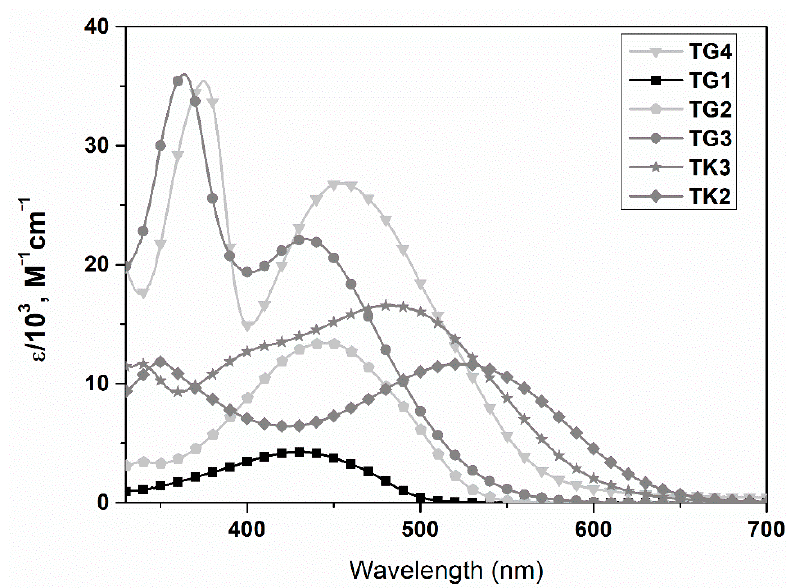
18 of 30 Figure 7. Dibenzofulvene (DBF)-based organic-dyes. TG1 and TG2 are two basic structures without donor groups on the DBF unit, and containing one or two thiophene rings, respectively, as spacer between the ylidene system and the cyanoacrylic acceptor unit. TG3 and TG4 can be considered as deriving from TG1 and TG2 , respectively, with the introduction of the diphenylamine donor unit in the 2,7-